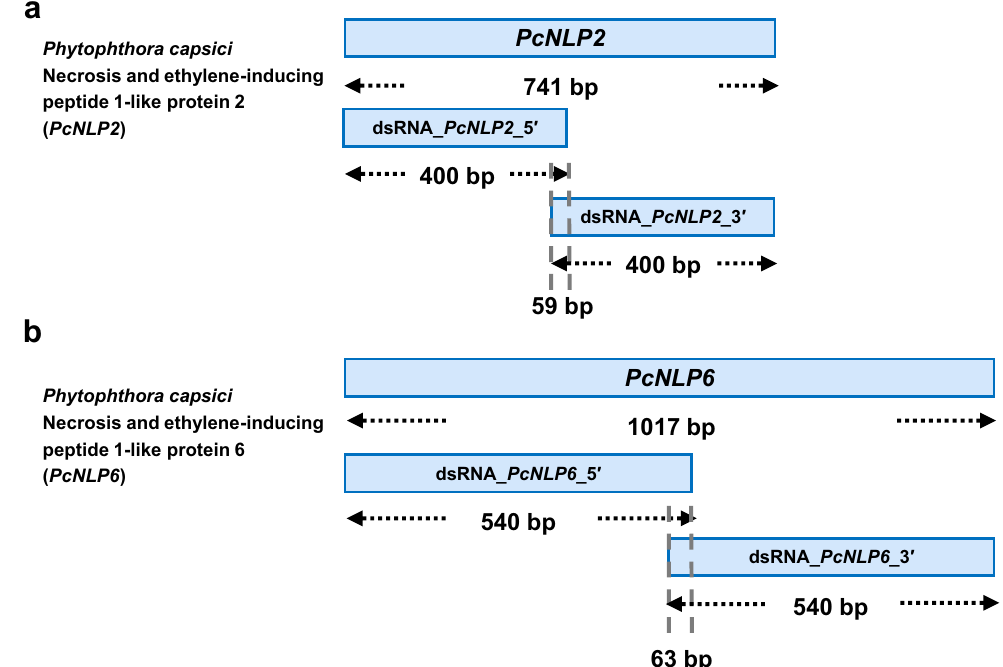
Fig. 1 Design of double-stranded RNAs (dsRNAs) targeting PcNLP2 and PcNLP6 . a dsRNA_ PcNLP2 _5 ′ and dsRNA_ PcNLP2 _3 ′ were designed to target the 5 ′ and 3 ′ regions of the PcNLP2 mRNA sequence, respectively. Each dsRNA was 400 bp in length, with a 59 bp overlap between them.